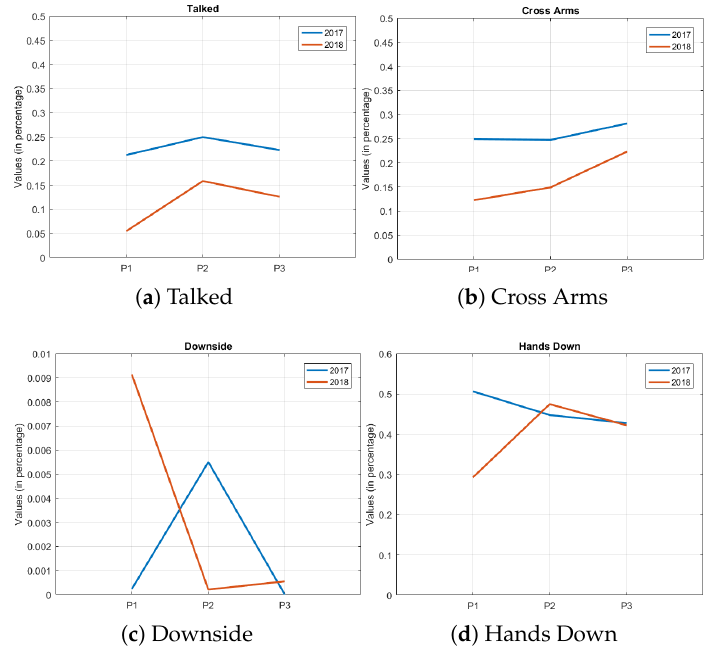
Figure 4. Trend graphs between the